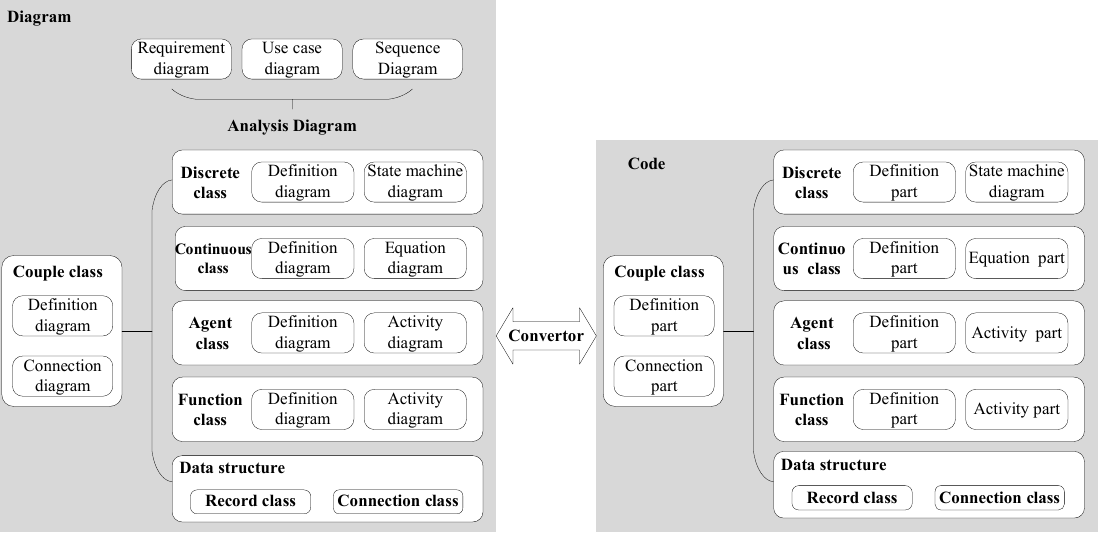
Figure 2. Class and elements of X